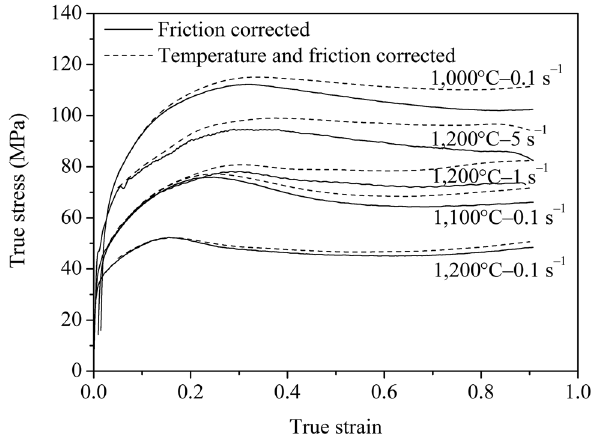
Figure 5: Comparison between the double-corrected and friction- corrected flow stress.